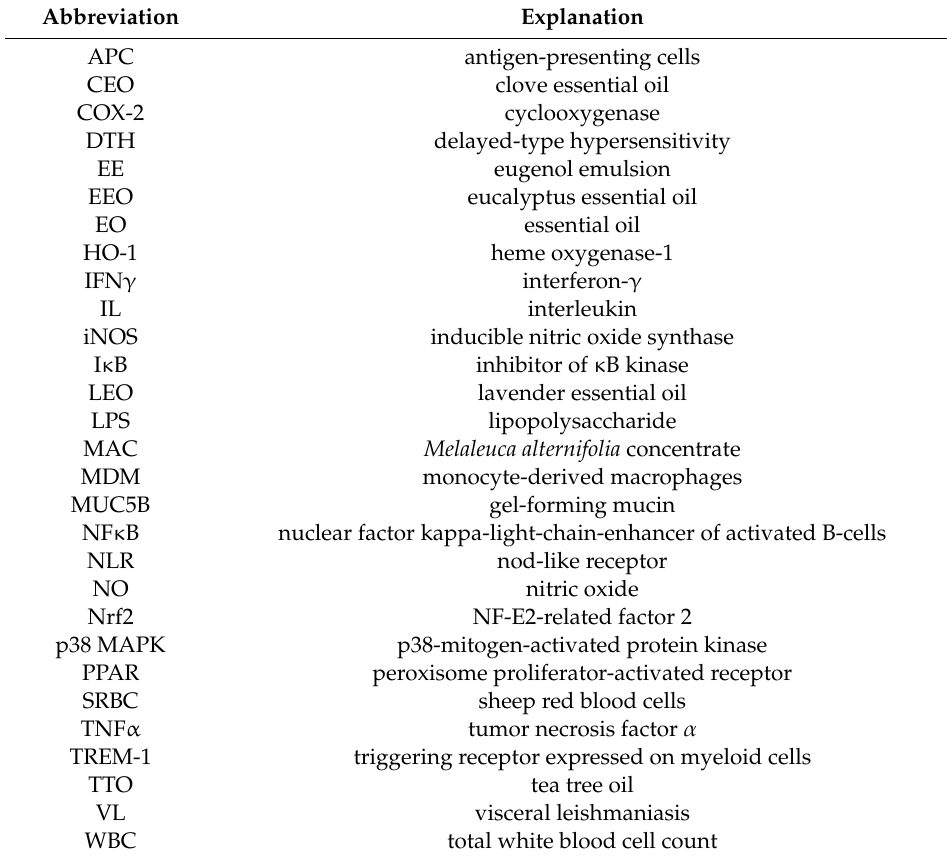
Table A1. List of